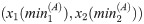
Hypoxia gradients and segmented tissue areas.Left panel: verifying the hypoxia gradient image feature against empirically measured and statistically bounded values. (A) The trajectory obtained by starting at (x1(min1(A)),x2(min2(A))) in a necrotic (N) region, locating a hypoxic (H) region, and then descending the hypoxia (p = anti-pimonidazole) gradient into a viable (V) region to reach the vessel centroid at (x1(max1(A)),x2(max2(A))), using the ∇−(x1, x2, p) gradient following function. (B) The trajectory obtained by starting at the vessel centroid at (x1(min1(B)),x2(min2(B))) in the viable (V) region, then ascending the hypoxia (p = anti-pimonidazole) gradient into a hypoxic (H) region until reaching a necrotic (N) region at (x1(max1(B)),x2(max2(B))), using the ∇+(x1, x2, p) gradient following function. Right panel: verifying the viable-to-hypoxic area ratio (C=A(V)A(H)) image feature against empirically measured and statistically bounded values.